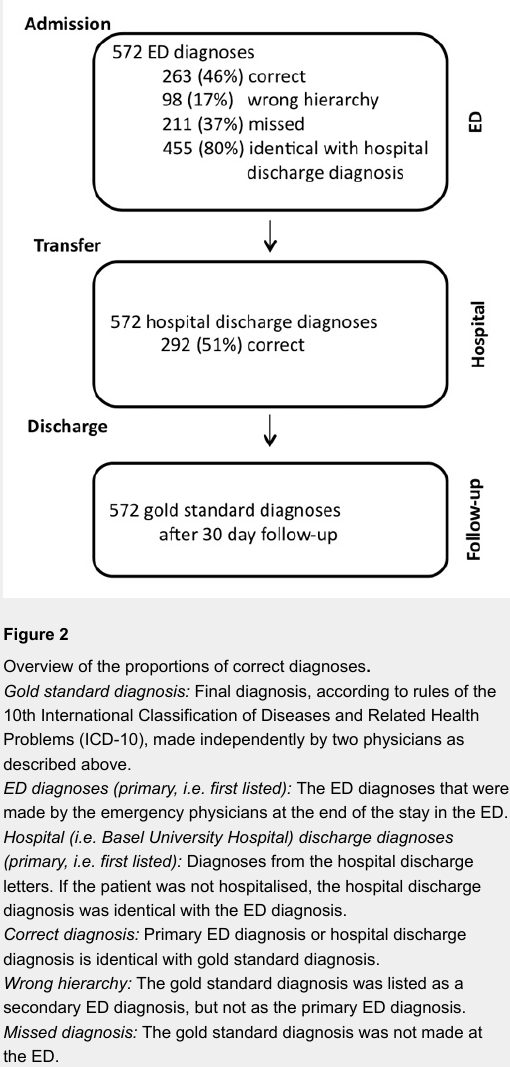
Gold standard diagnosis: Final diagnosis, according to rules of the 10th International Classification of